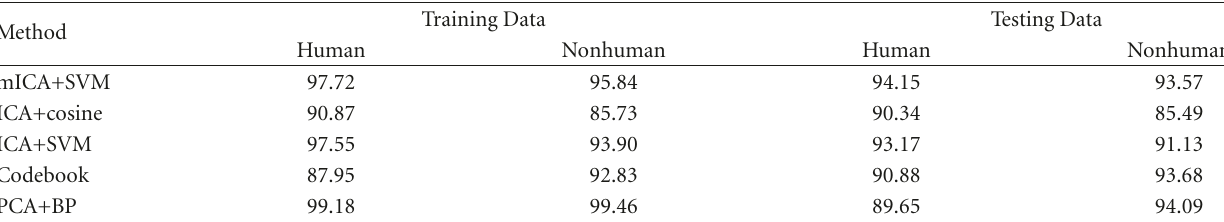
Table 3: Accuracy of human detection system